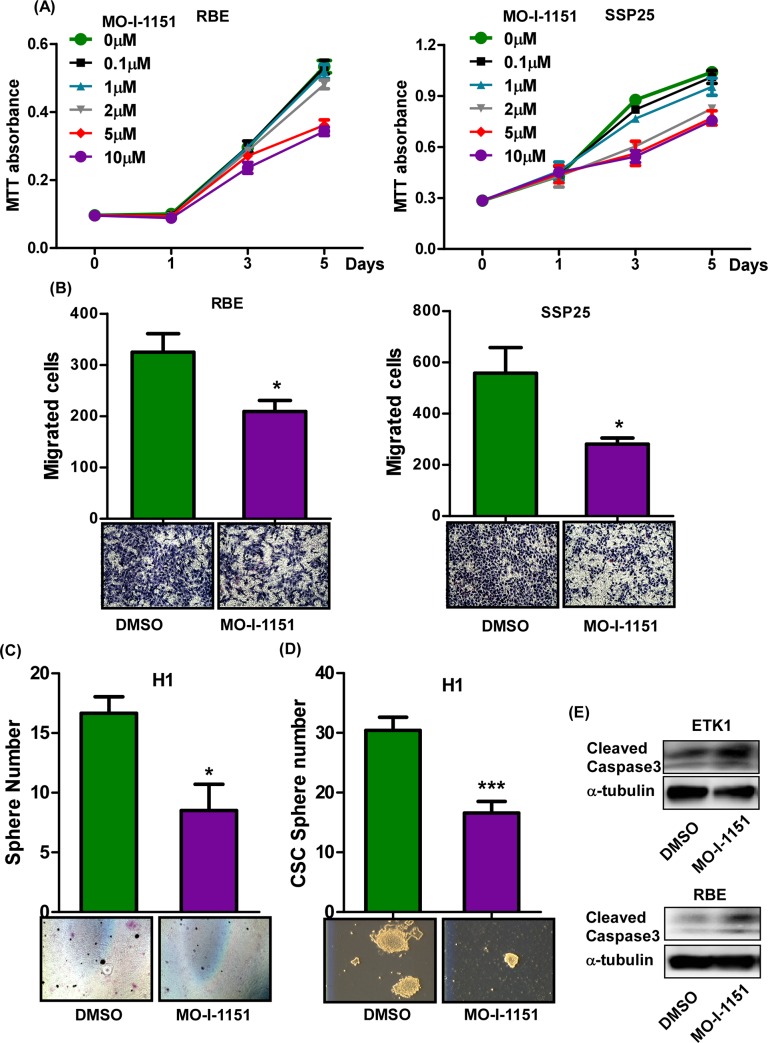
Functional characterization of a SMI, MO-I-1151 on CCA phenotype.Relative cell proliferation rates were measured using MTT assay at day 0, 1, 3, and 5 in RBE and SSP25 cells (A). (B) Migrated cell numbers were determined in RBE and SSP25 in the presence or absence of 5 μM MO-I-1151. (C) Colony formation in soft agar was determined in H1 cells treated with or without MO-I-1151 at 5 μM. (D) Formation of CSC spheres were determined in H1 cells treated with DMSO or 5 μM MO-I-1151. (E) MO-I-1151 also increased caspase 3 cleavage in ETK1 and RBE cells. ***, p <0.001; *, p <0.05.